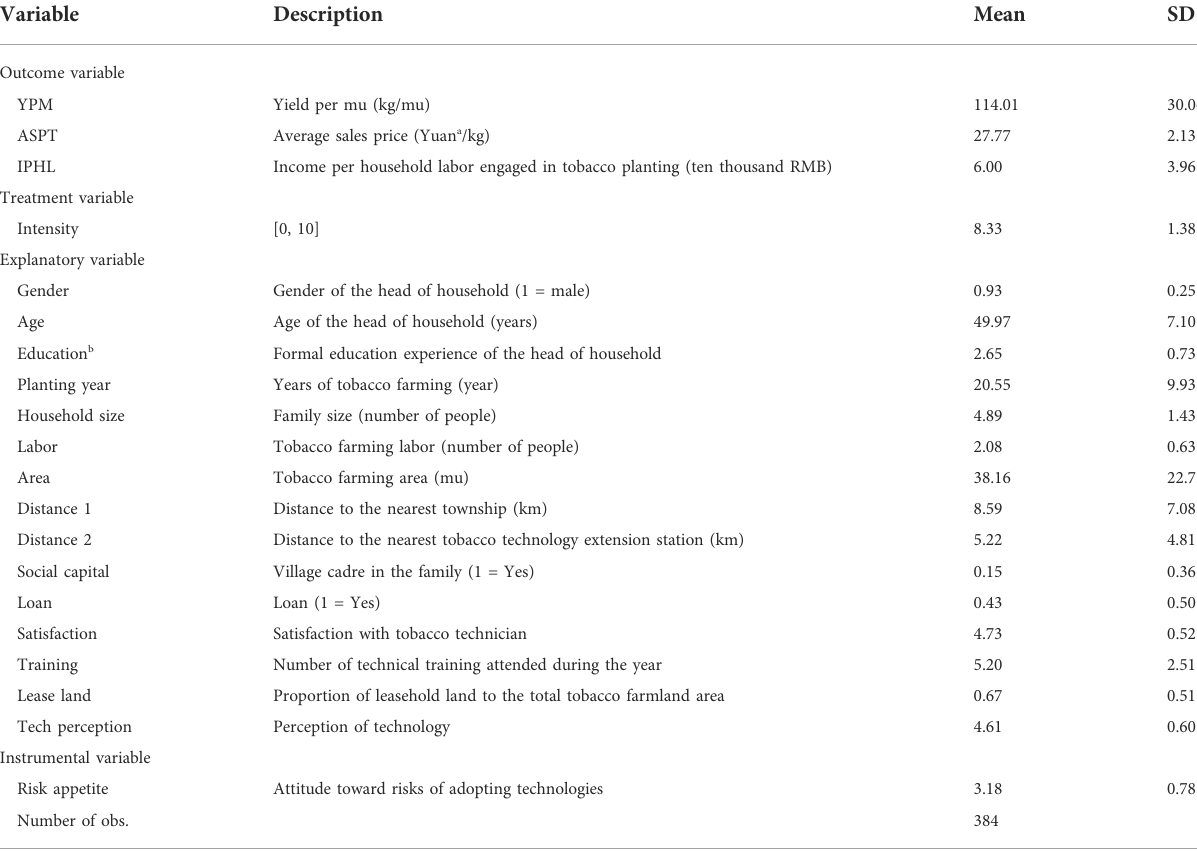
TABLE 3 Descriptive statistics of variables.